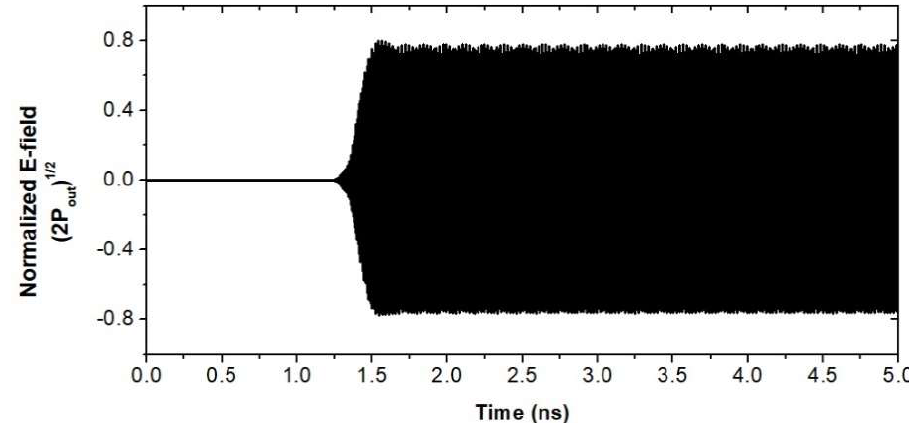
Figure 9. The output signal of the HHTWT at 346 GHz.